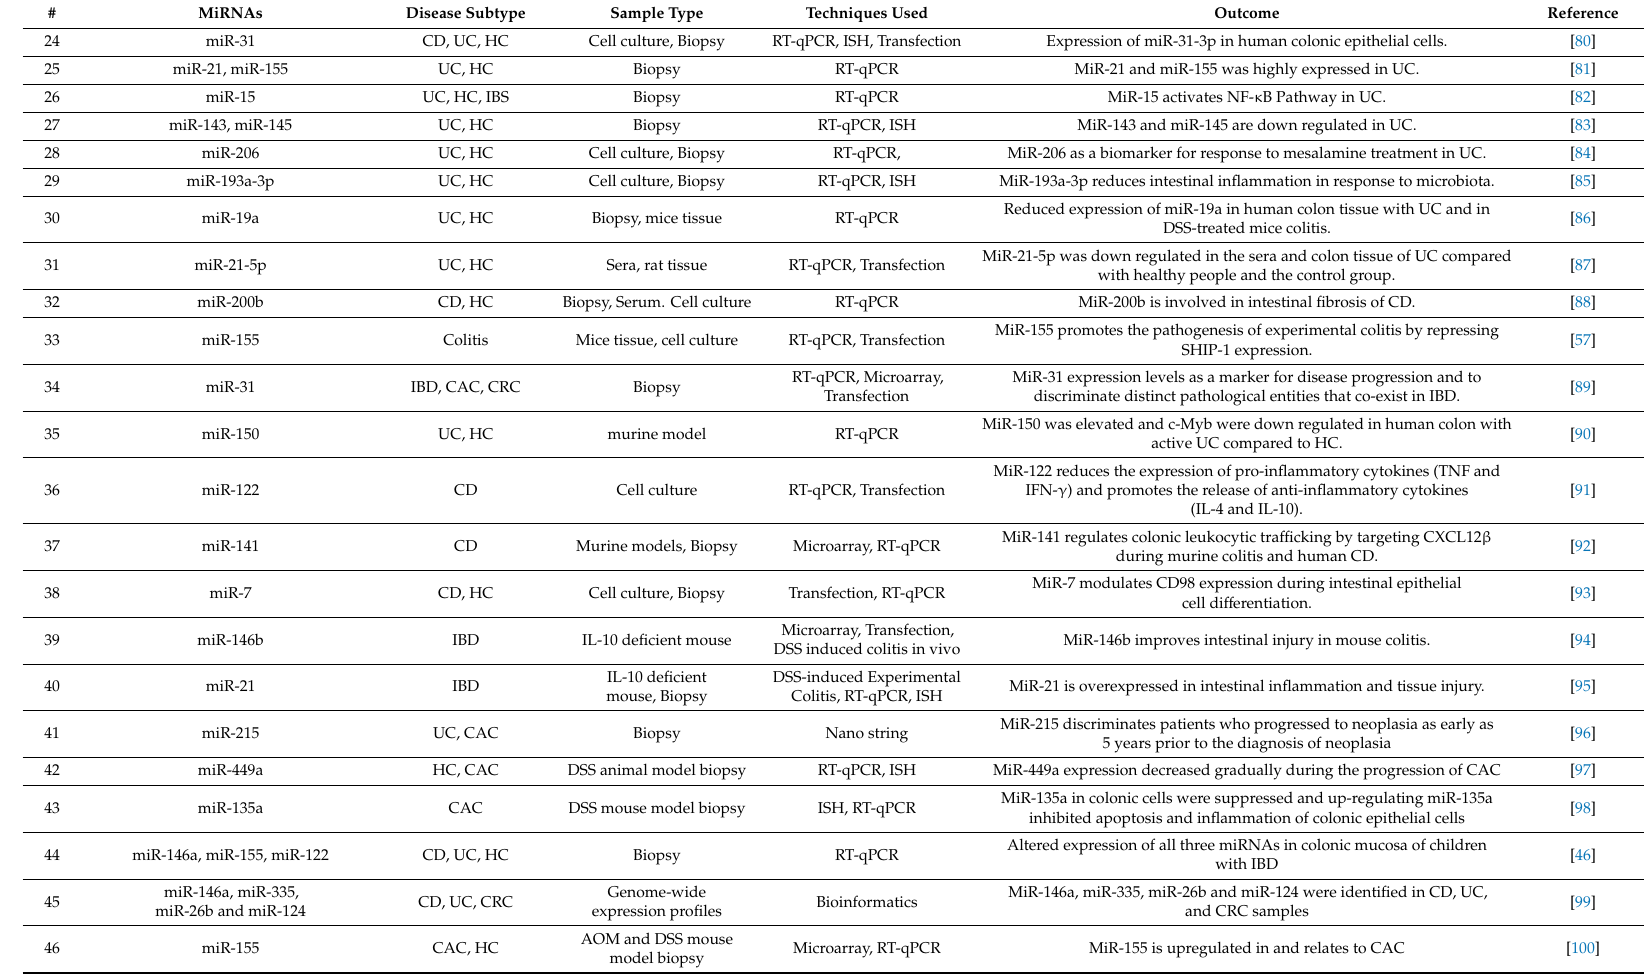
MiR-21 is overexpressed in intestinal inflammation and tissue